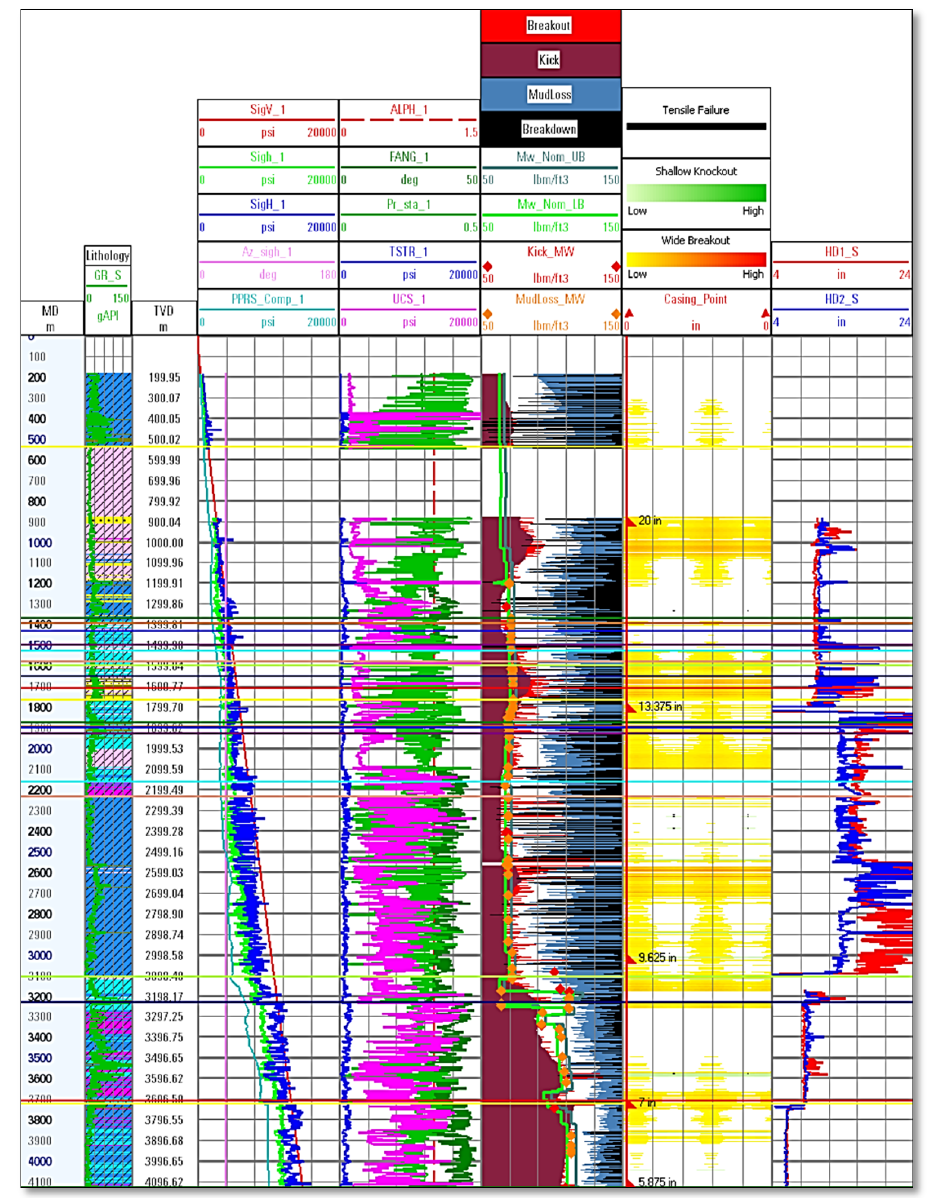
Figure 9. 1D MEM for three available wells in the field (Well-1: top , Well-2: middle , Well-3: bottom ). Note the accurate match between observed drilling events and the predicted ones. First tracks are showing: Vertical stress, minimum horizontal stress, maximum horizontal stress and along with pore pressure, Second tracks are showing: Biot’s coefficient, Friction angle, Poisson’s ratio, Tensile strength and UCS, Third tracks are showing: Kick, breakout, loss and breakdown boundaries along with the mud weight used while drilling, Forth tracks are showing: Failures predicted from the model, Fifth tracks are showing: caliper data. A good match between predicted failures and caliper data can be noted.